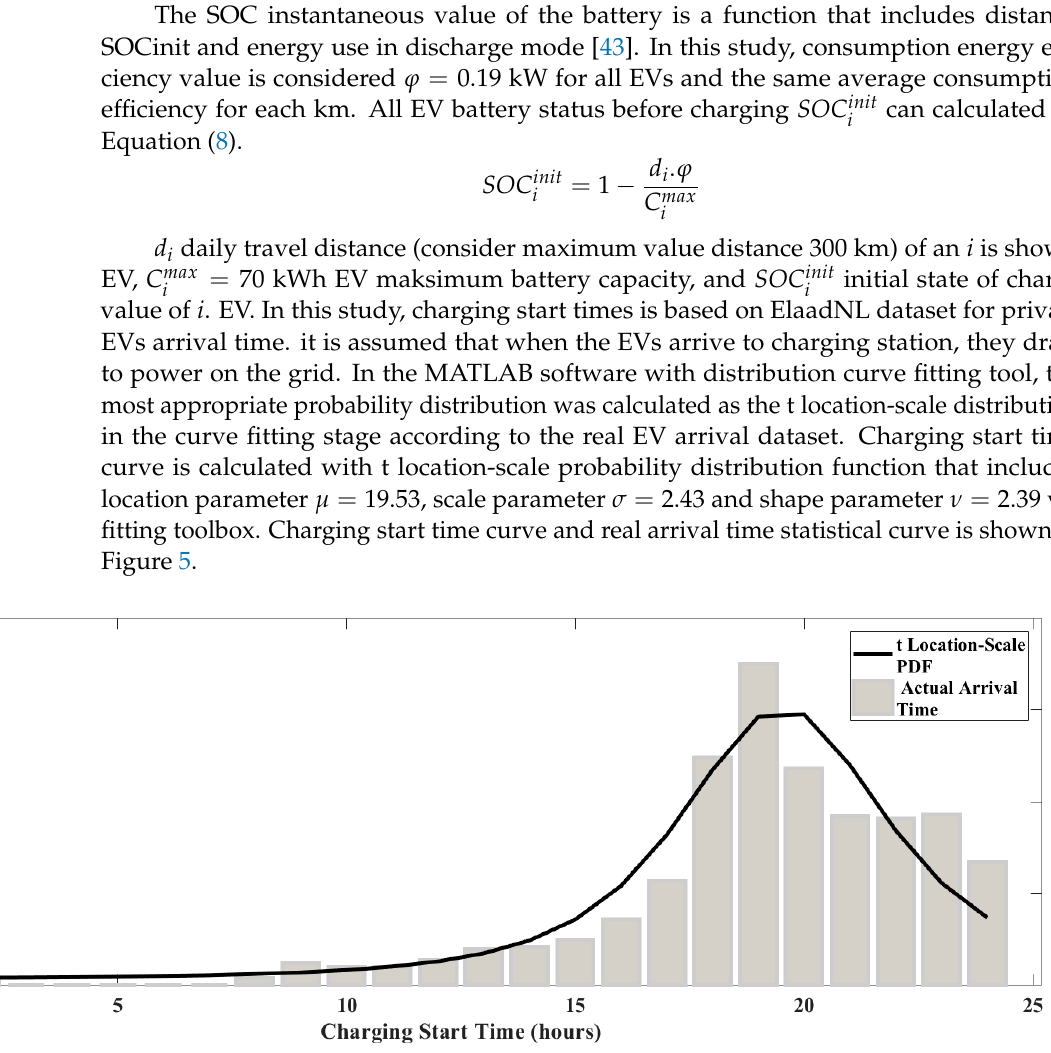
Figure 5. Probability distribution of charging start